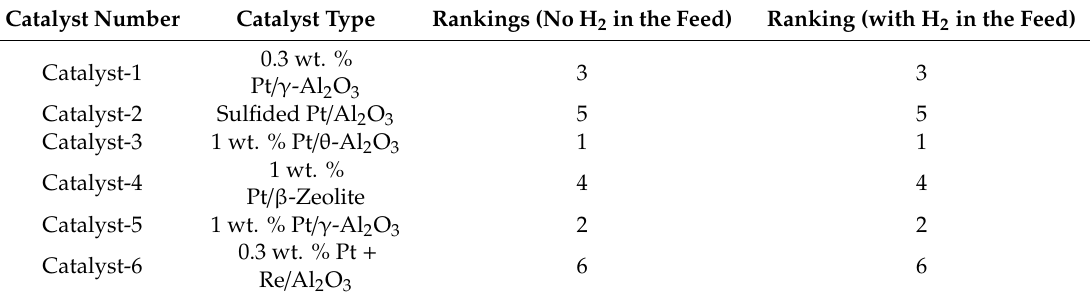
Table 8. Final rankings of the dehydrogenation reactor